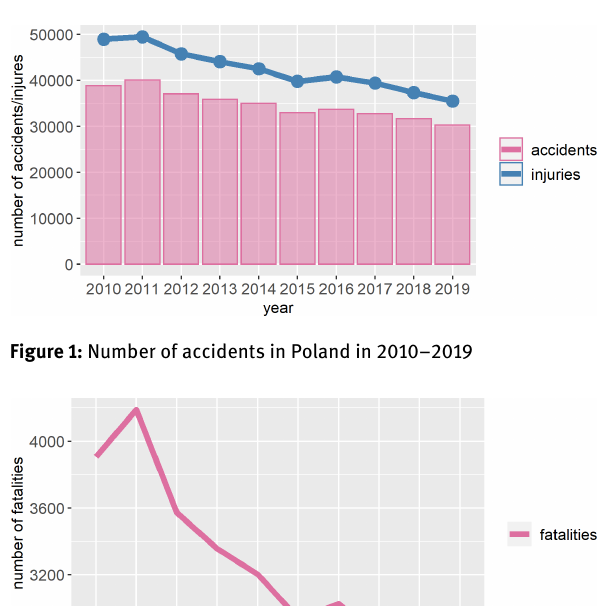
measures to reduce the number of accident victims, as well as the social and economic consequences of such events.